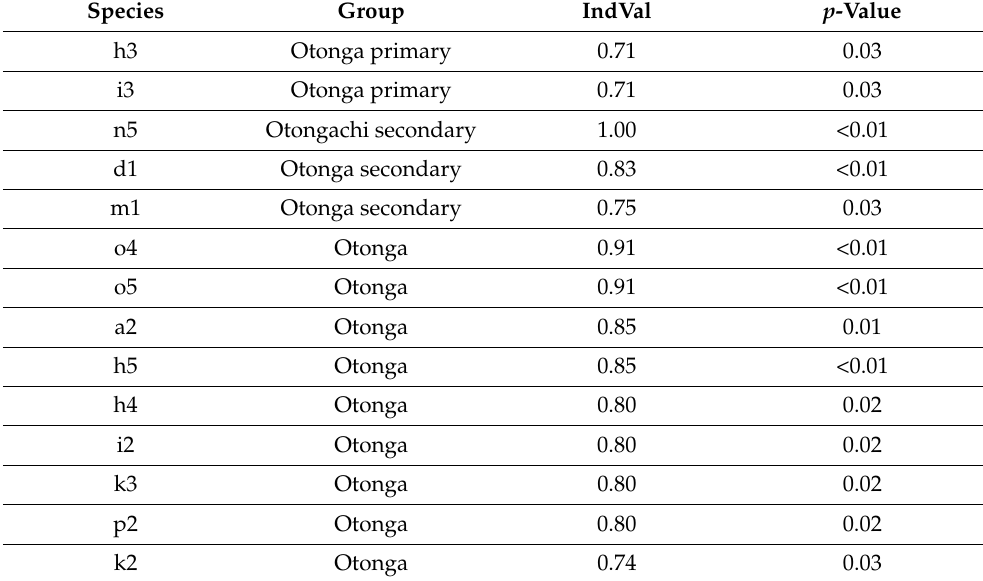
Table 2. Species significantly associated with combinations of reserve/forest type. Species Group IndVal p -Value h3 Otonga primary 0.71 0.03 i3 Otonga primary Otongachi secondary